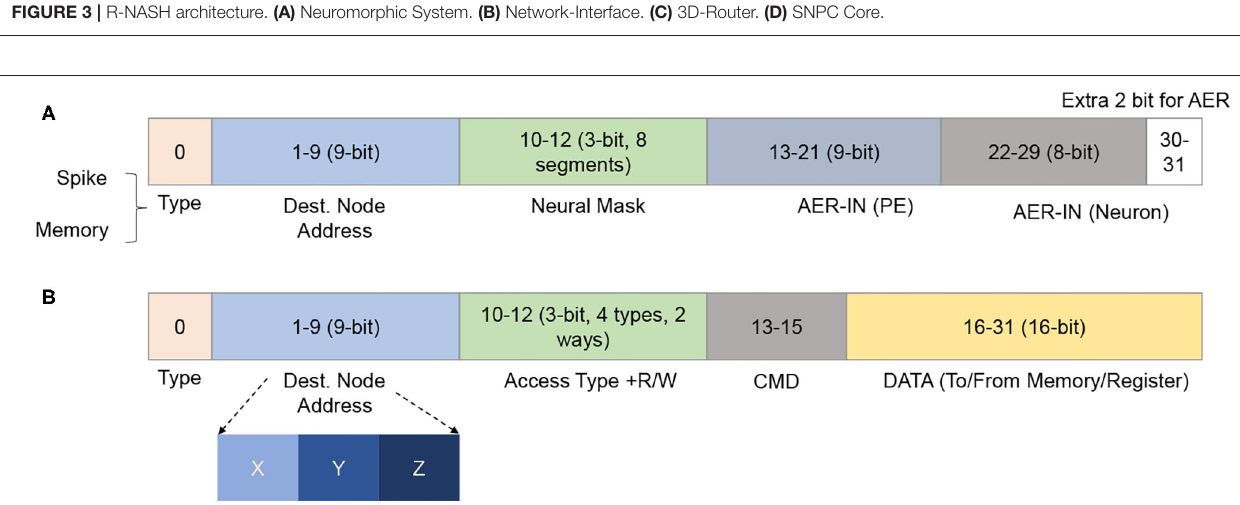
FIGURE 4 | R-NASH flit formats. (A) AER flit format. (B) Memory access flit